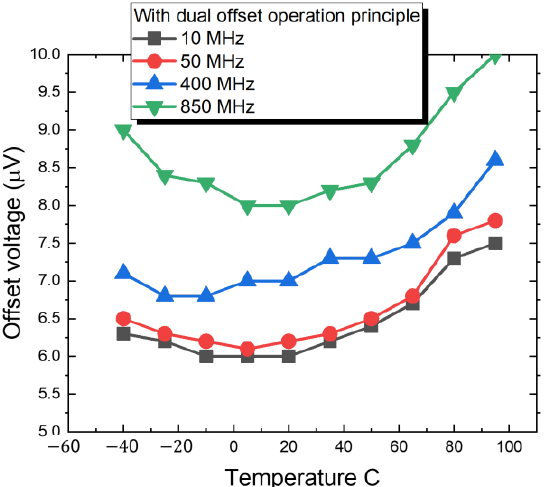
Figure 12. The measured result of the proposed comparator using dual offset cancellation technique.